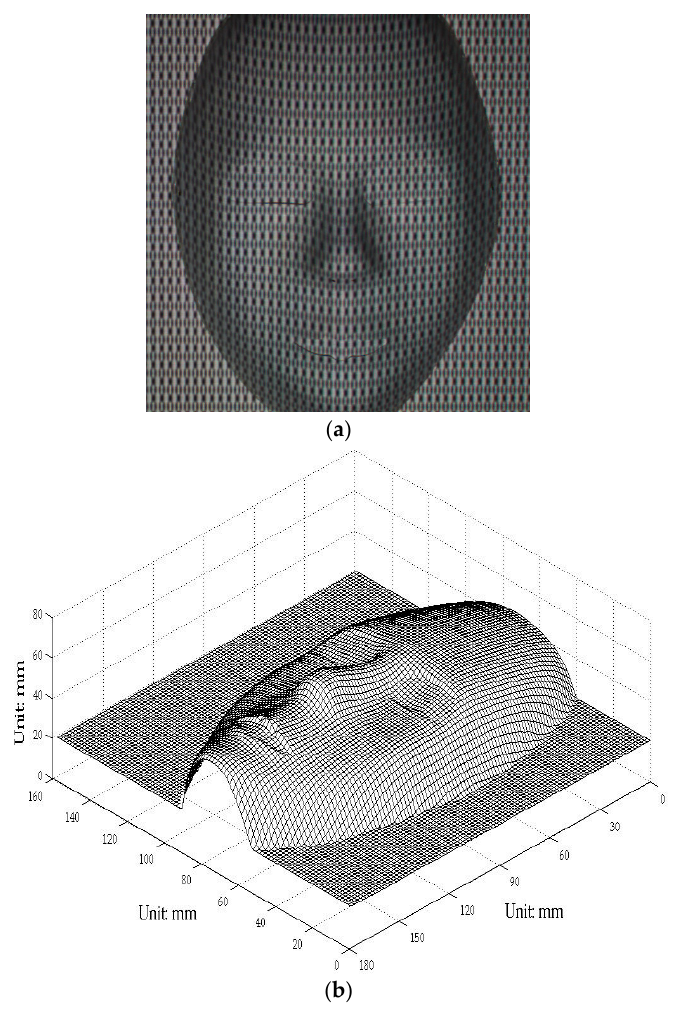
Figure 7. ( a ) Captured distortion composite pattern modulated by the model; ( b ) rebuilt 3D model profile from the composite pattern.